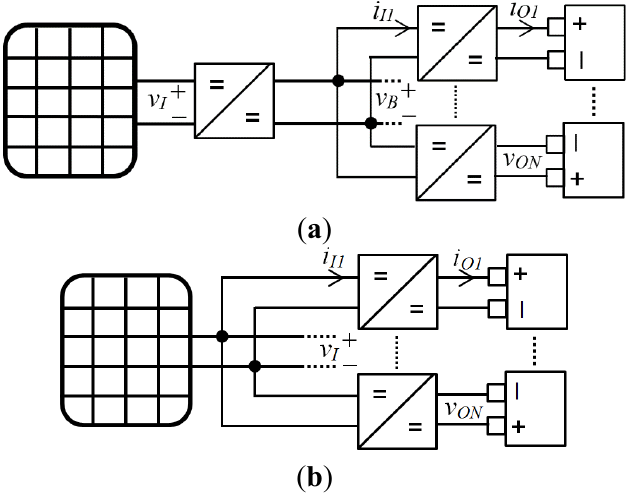
Figure 1. Single source multi battery solar charger topologies: ( a ) typical; ( b )